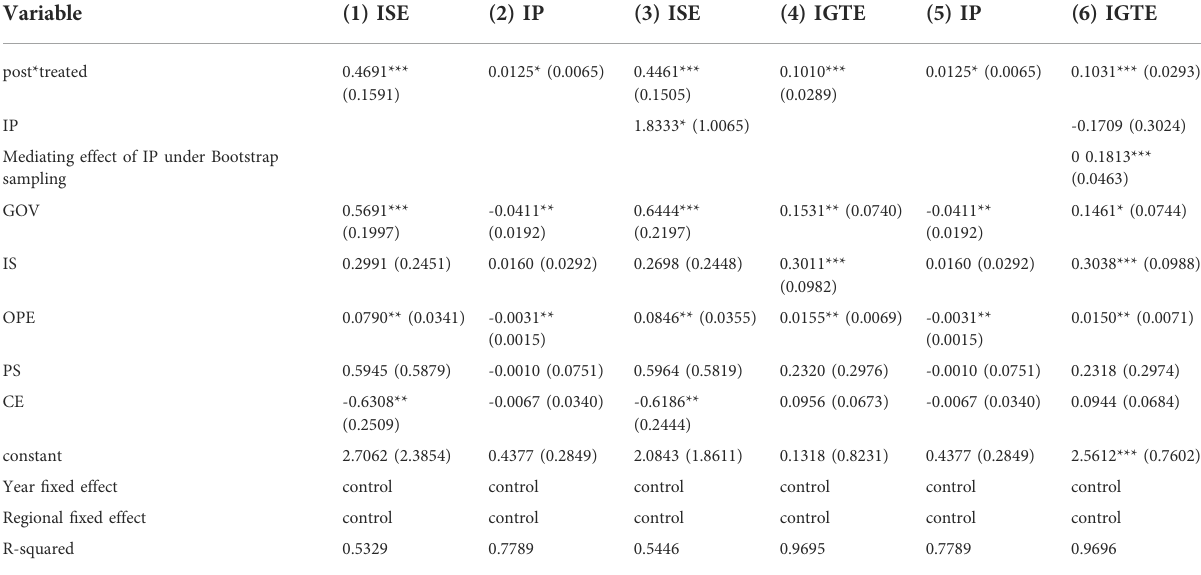
TABLE 8 Mediating effect of innovation protection intensity.